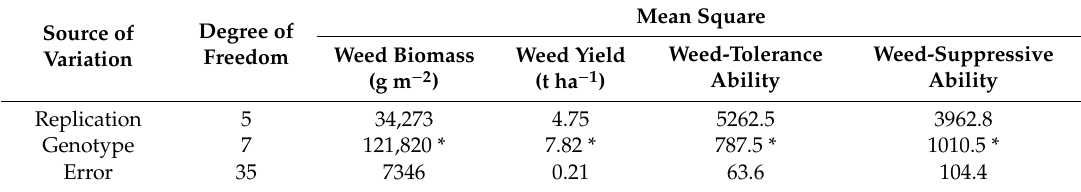
Table3. Analysesofvarianceshowinggenotypee ff ectsontheweedbiomass, weedyield, weed-tolerance ability, and weed-suppressive ability.